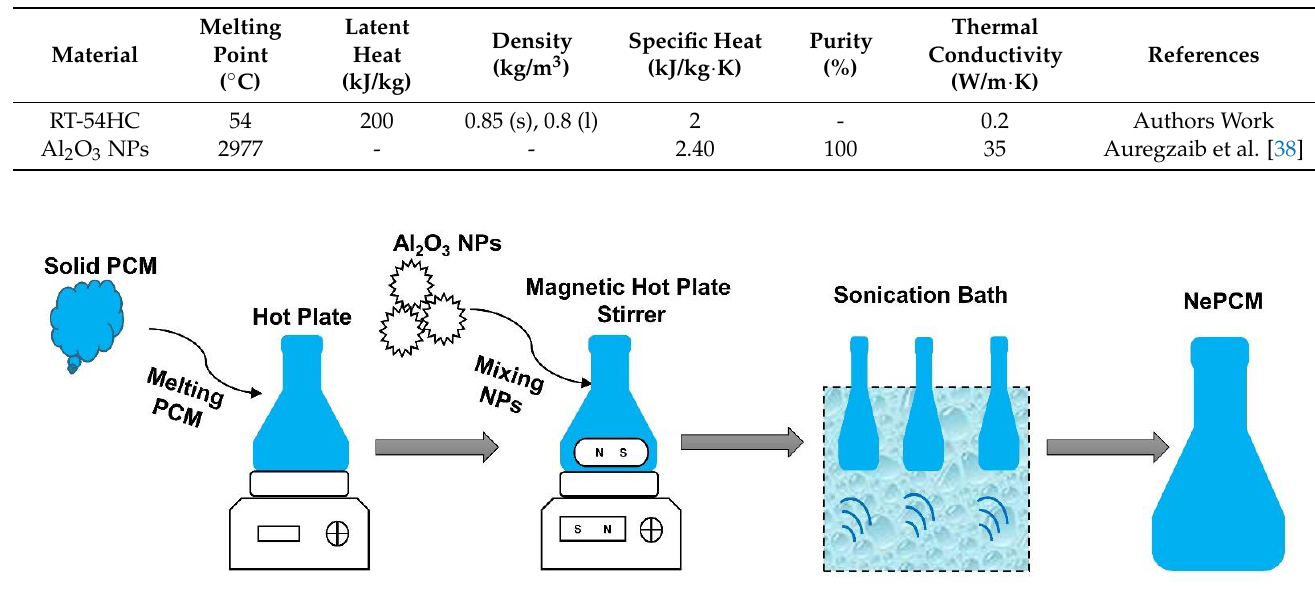
Table 4. Properties of the PCM and alumina NPs.